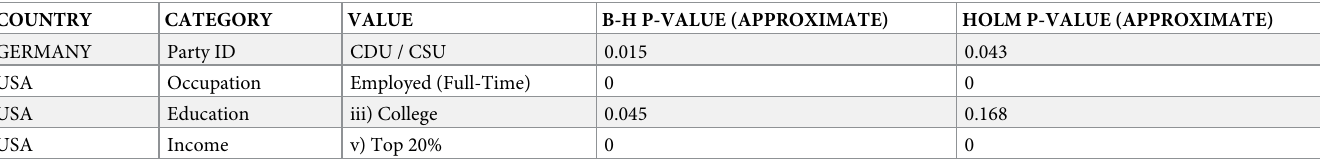
Table 1. p-values for the difference between the list experiment and direct item, corrected for multiple